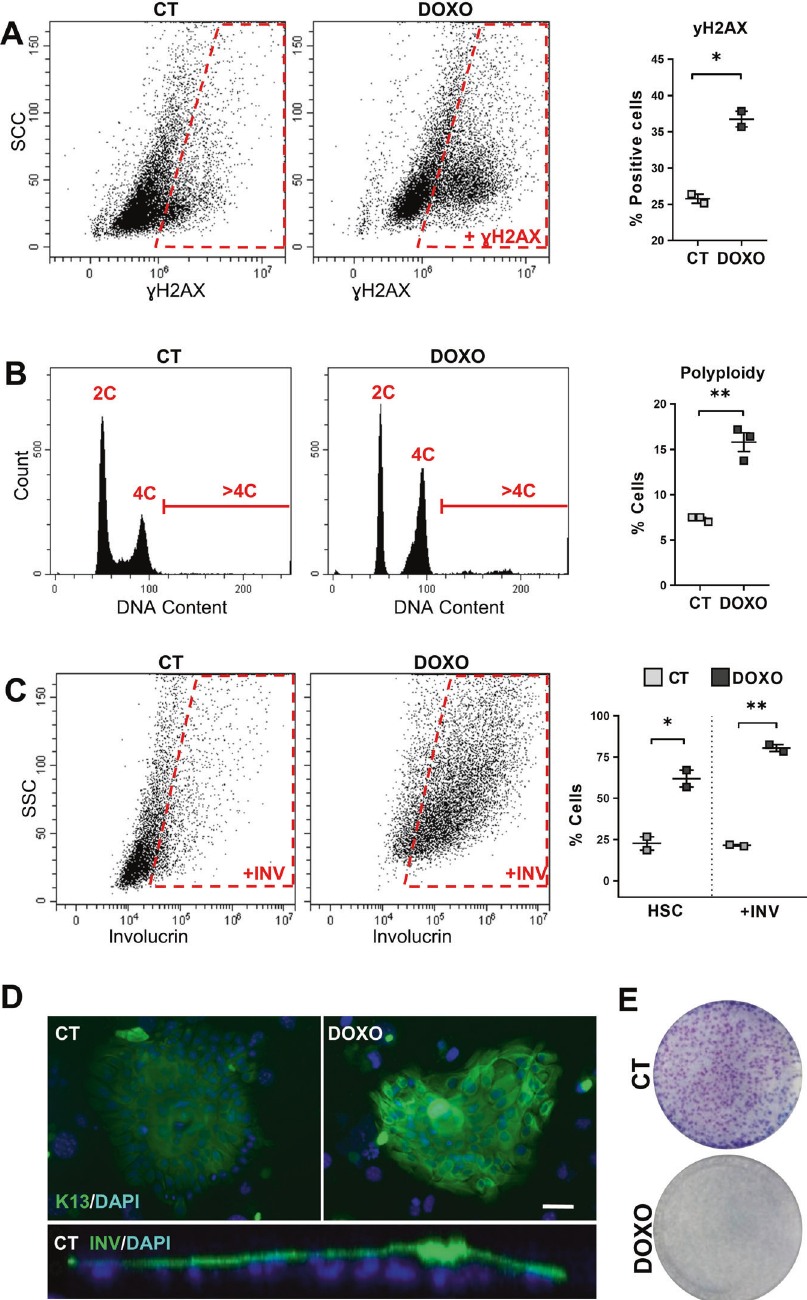
Fig. 3 Doxorubicin induces squamous metaplasia in human mammary gland epithelial cells. Human primary mammary gland epithelial cells were treated with dimethyl sulfoxide (CT) or with 0.5 μ M Doxorubicin (DOXO) for 48 h, as indicated. A Representative fl ow cytometry analysis for the DNA damage marker γ H2AX ( + γ H2AX, positive cells). The percent of + γ H2AX is shown on the right. B Representative fl ow cytometry analyses of DNA content (2C, 4C, and >4C). The percent of polyploid cells (>4C) is shown on the right. C Representative fl ow- cytometry analysis for the differentiation marker involucrin ( + INV, positive cells). The percent of cells with high light scatter (HSC), or + INV is shown on the right, as indicated. D Top: representative mammary gland colonies after immuno fl uorescence for keratin K13 (green), treated as indicated. Blue is nuclear DNA by DAPI. Scale bar, 50 μ m. Bottom: Orthogonal view pro fi le of a CT mammary gland colony after immuno fl uorescence for involucrin (INV). E Clonogenic capacity of cells plated after 48 h treatment as indicated and drug-released. Positive cells by fl ow cytometry were gated according to negative isotype antibody control. Data are mean ± SEM of duplicate or triplicate samples, representative of two independent experiment from two different human individuals with similar results. ** p ≤ 0.01, * p ≤